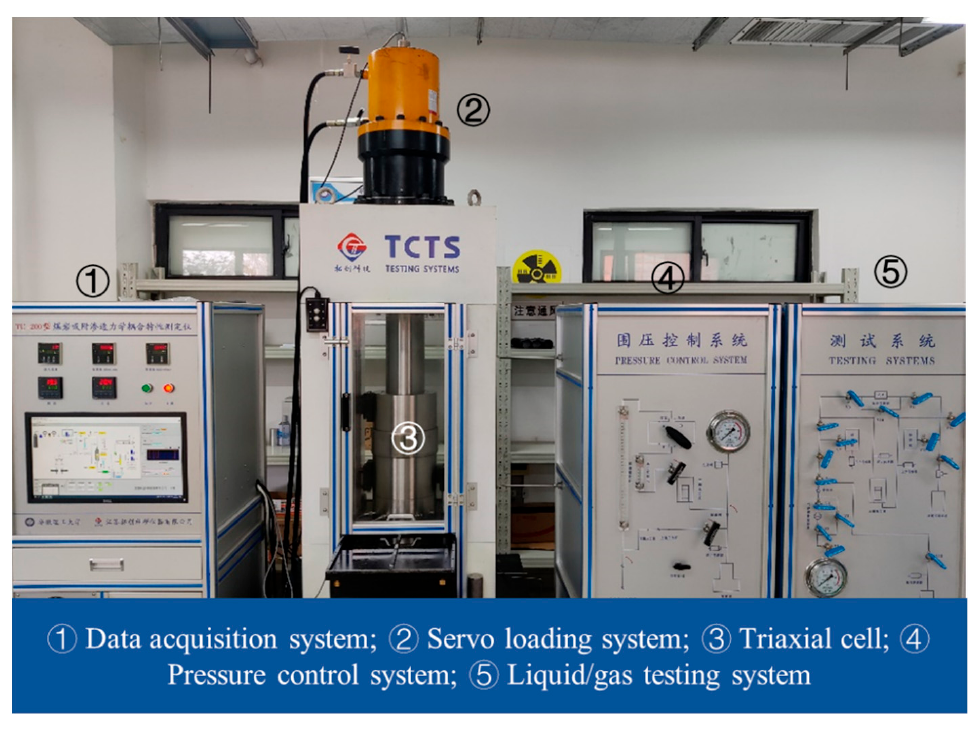
Figure 2. Triaxial servo ‐ controlled mechanical–seepage coupling experimental apparatus [29].